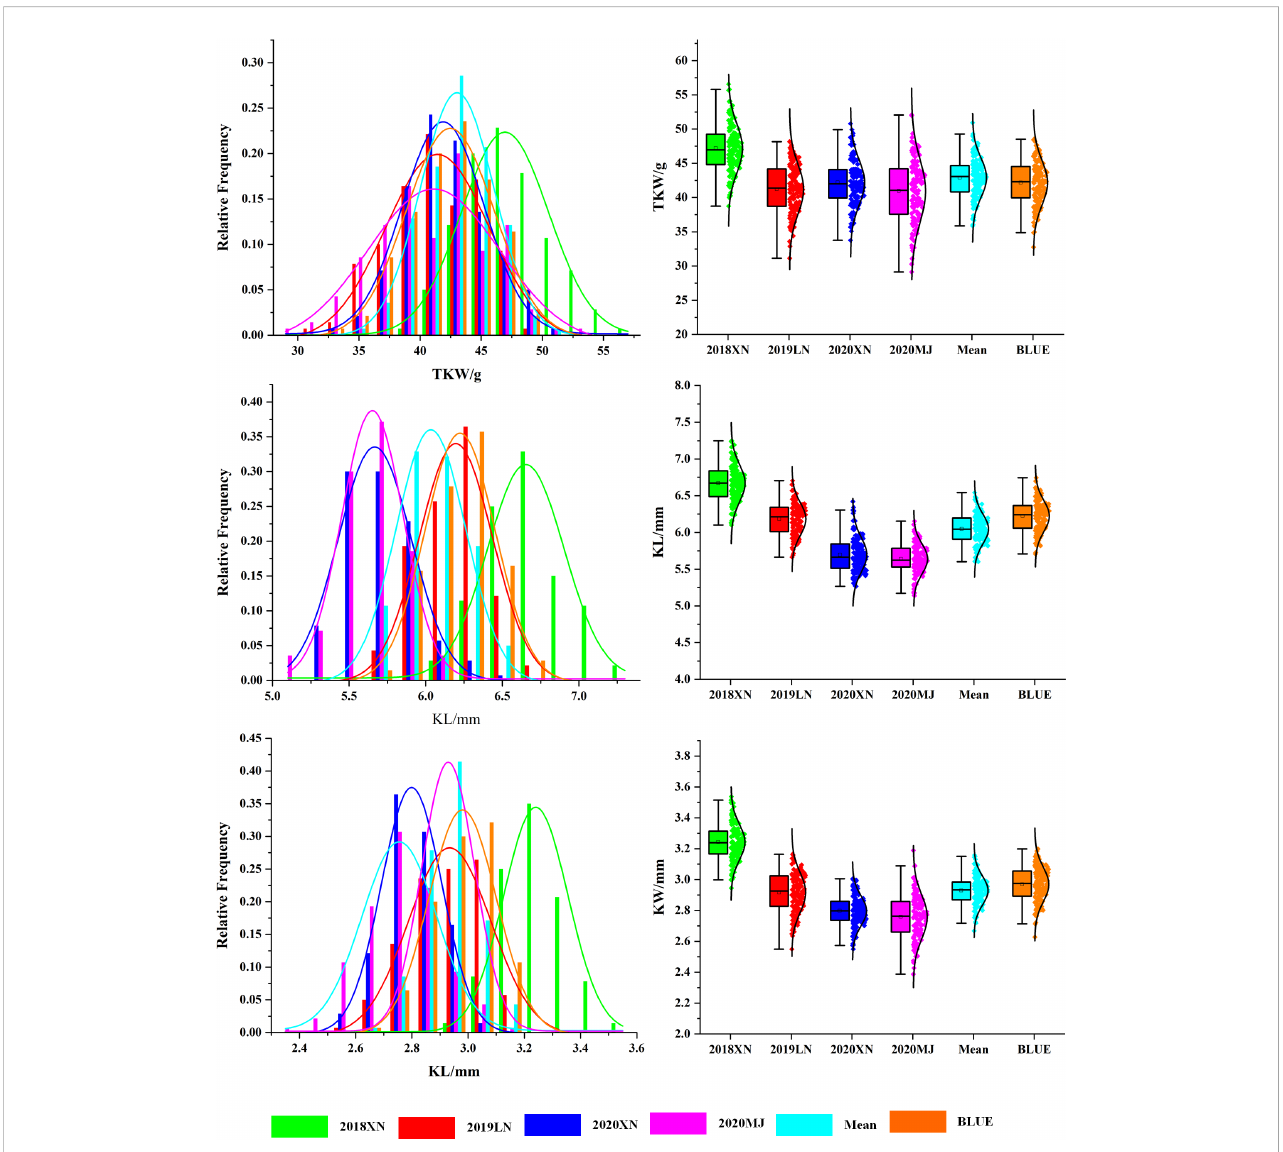
FIGURE 1 Histograms of distributions for wheat kernel traits in the Avocet/Chilero RIL population. Note: 2018XN: The farm of Henan University of Science and Technology 2018 – 2019, 2019LN: Luoning 2019 – 2020, 2020XN: The farm of Henan University of Science and Technology 2020 – 2021, 2020MJ: Mengjin 2020 – 2021. Green represents 2018XN, red represents 2019LN, blue represents 2020XN, magenta represents 2020MJ, cyan represents mean values, and orange represents